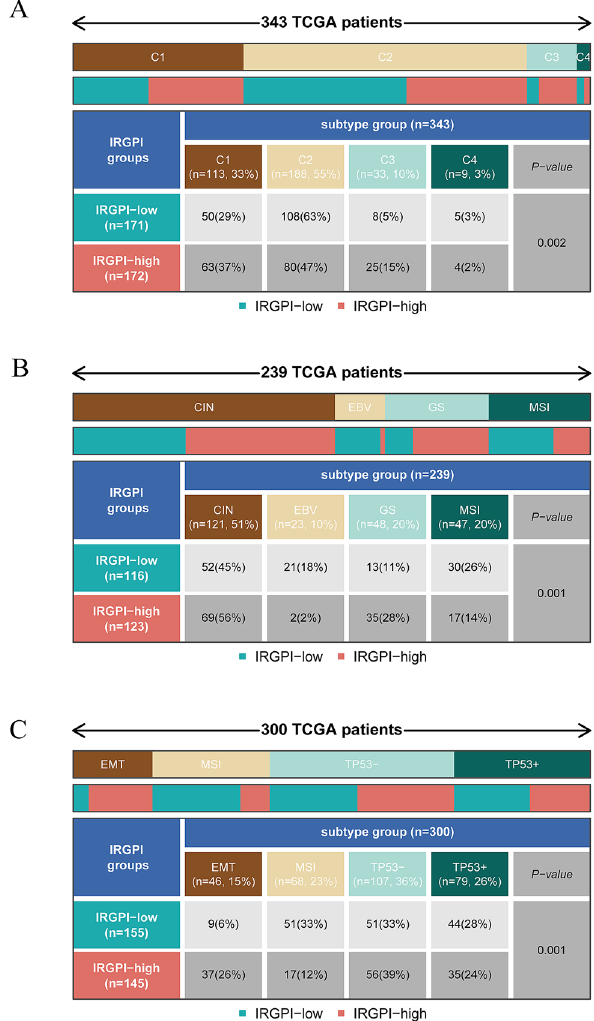
Figure 4. The distribution of immune and molecular subtypes in different IRGPI groups. ( A ) The distribution of TCGA immune subtypes between IRGPI groups in TCGA-STAD cohort. ( B ) The distribution of molecular subtypes between IRGPI groups in TCGA-STAD cohort. ( C ) The distribution of ACRG subtypes between IRGPI groups in GSE62254 cohort. [Figures created by R, version